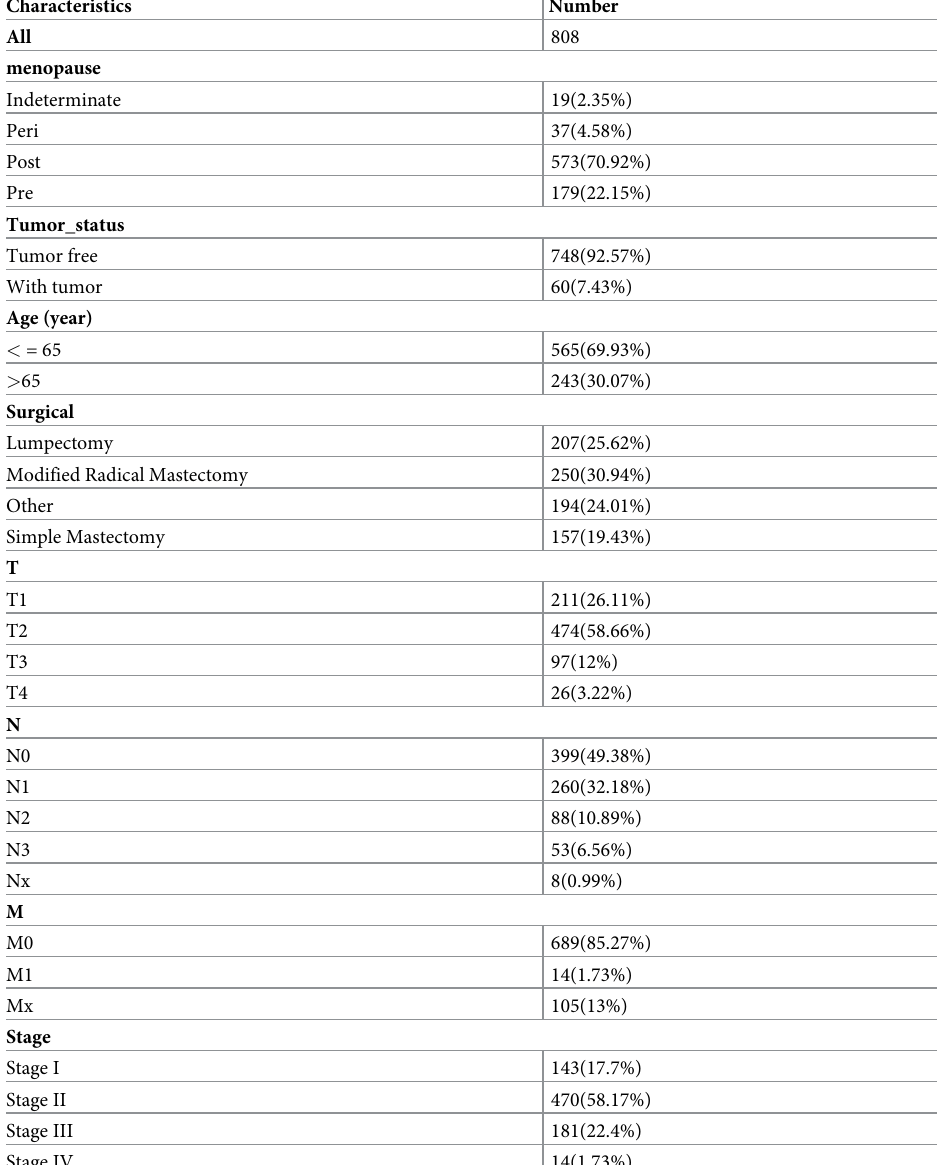
Table 1. Characteristics of the 808 breast cancer (BCa) patients in the present